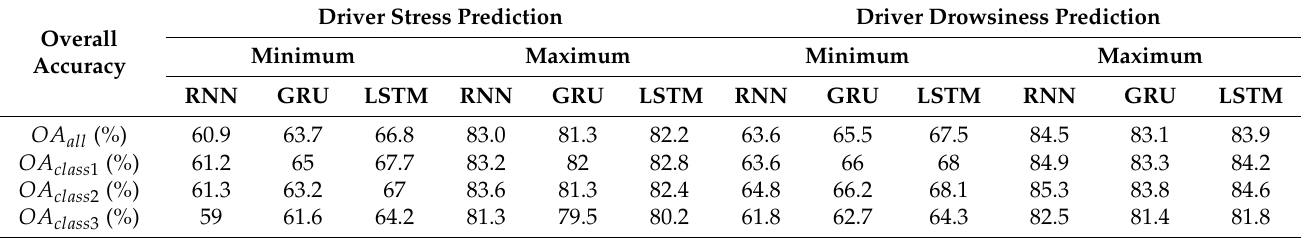
and driver drowsiness prediction models using individual RNN, GRU, and LSTM Table 2. Summary of the maximum and minimum 𝑂𝐴 (cid:3028)(cid:3039)(cid:3039) , 𝑂𝐴 (cid:3030)(cid:3039)(cid:3028)(cid:3046)(cid:3046)(cid:2869) , 𝑂𝐴 (cid:3030)(cid:3039)(cid:3028)(cid:3046)(cid:3046)(cid:2870) , and 𝑂𝐴 (cid:3030)(cid:3039)(cid:3028)(cid:3046)(cid:3046)(cid:2871) for the driver stress prediction and